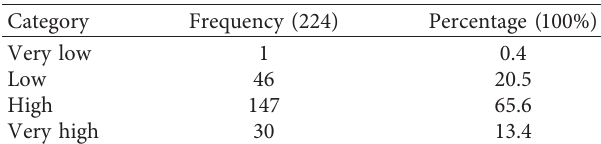
Table 2: Respondents’ level of satisfaction with clinical rotation experience.